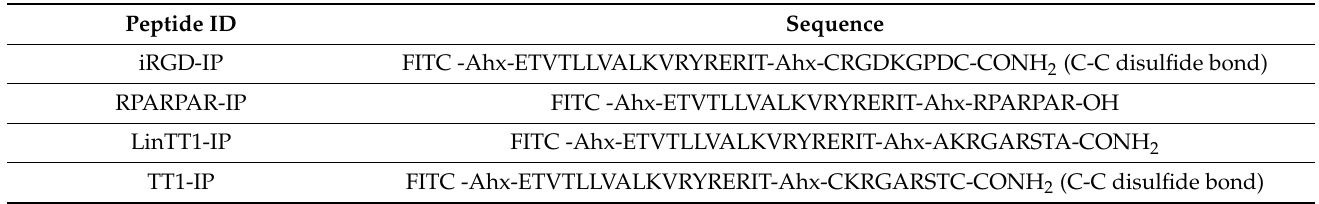
Table 2. Sequence of the peptides used in this